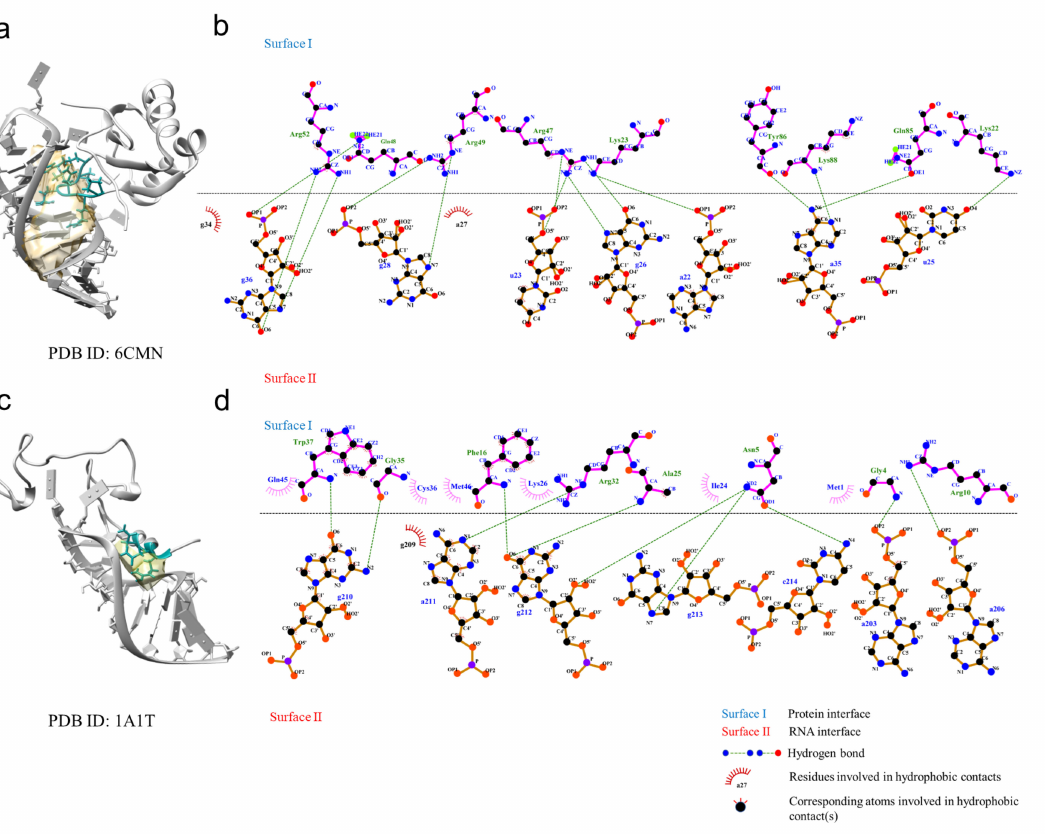
Figure 6. Examples of RNA-binding pocket proteins. ( a ) The structure of HIV-1 TAR RNA binds to the RNA recognition motif (PDB ID: 6CMN). ( b ) Hydrogen bond and hydrophobic contacts for the RNA–protein interface (PDB ID: 6CMN). ( c ) The structure of HIV-1 nucleocapsid protein binds to the SL3 psi-RNA (PDB ID: 1A1T). ( d ) Hydrogen bond and hydrophobic contacts for the RNA–protein interface (PDB ID: